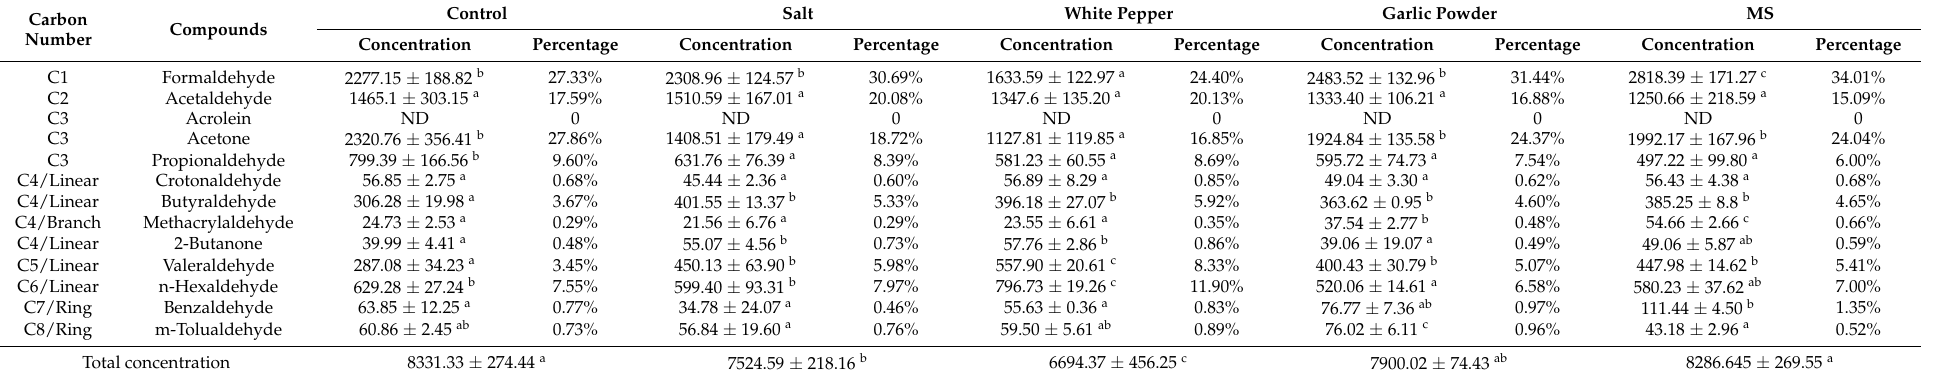
Table 5. The mean concentration of 13 target carbonyl compounds and their relative proportions